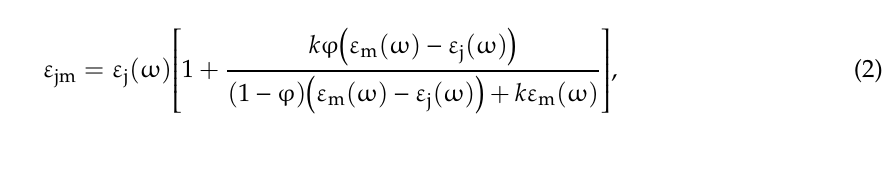
dielectric constant ( ε jm ) can be calculated in different ways if the volume fraction of the dispersed phase ( φ ) and the dielectric constants of the dispersed phase ( ε j ) and medium matrix ( ε m ) are known. Various models are used for estimating the effective dielectric constant. Different models have to be